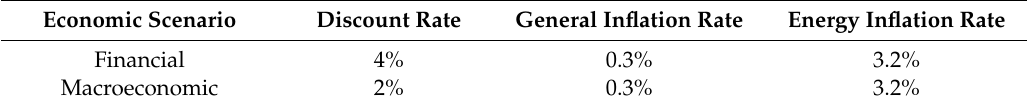
Table 5. Economic indexes employed for the economic